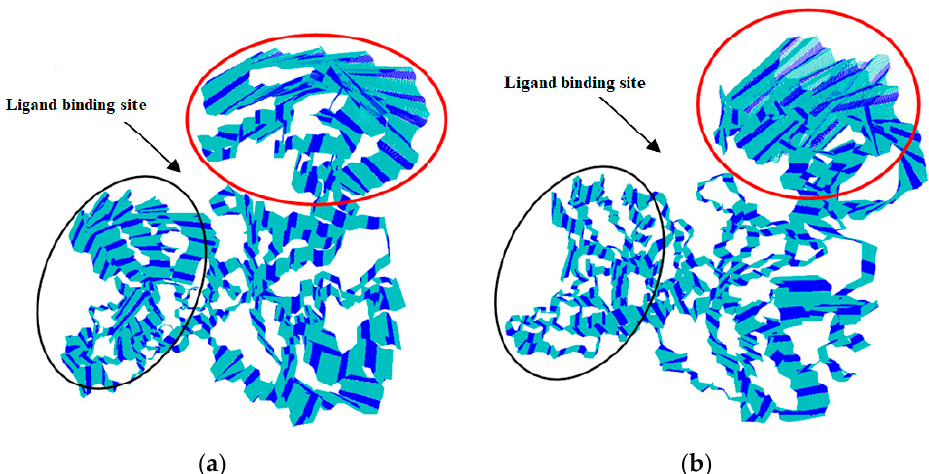
Figure 9. Movement of backbone atoms during simulation by 100 collectively aligned frames. ( b ) NuBBE-1970–NSP15 complex; ( a ) NuBBE-242–NSP15. Motion of backbone atoms of NuBBE-1970–NSP15 and NuBBE-242–NSP15 is as calculated by principal-component analysis (PCA). Comparison of the wide and narrow sections shown by red and black ellipses, where red ellipses showed tendency towards active ligand site (arrow). Width of bands was proportional to amplitude, signifying that atoms moved in a similar direction.